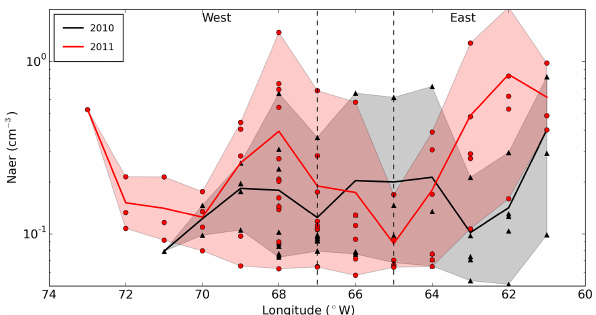
Figure 11. Same as Fig. 4 but for the number concentration of aerosols larger than 0.5µm and smaller than 1µm in diameter (cm − 3 ). Fifty-five flights are considered here (31 flights from both campaigns equipped with the CAPS probe but not intended for cloud measurements in addition to the 24 cloud flights) to increase the statistics and give better overview of the aerosol population across the peninsula for both years. See text (Sect. 3.3) for more details. The vertical dashed lines delimit the western and eastern regions of the peninsula as defined in this study.